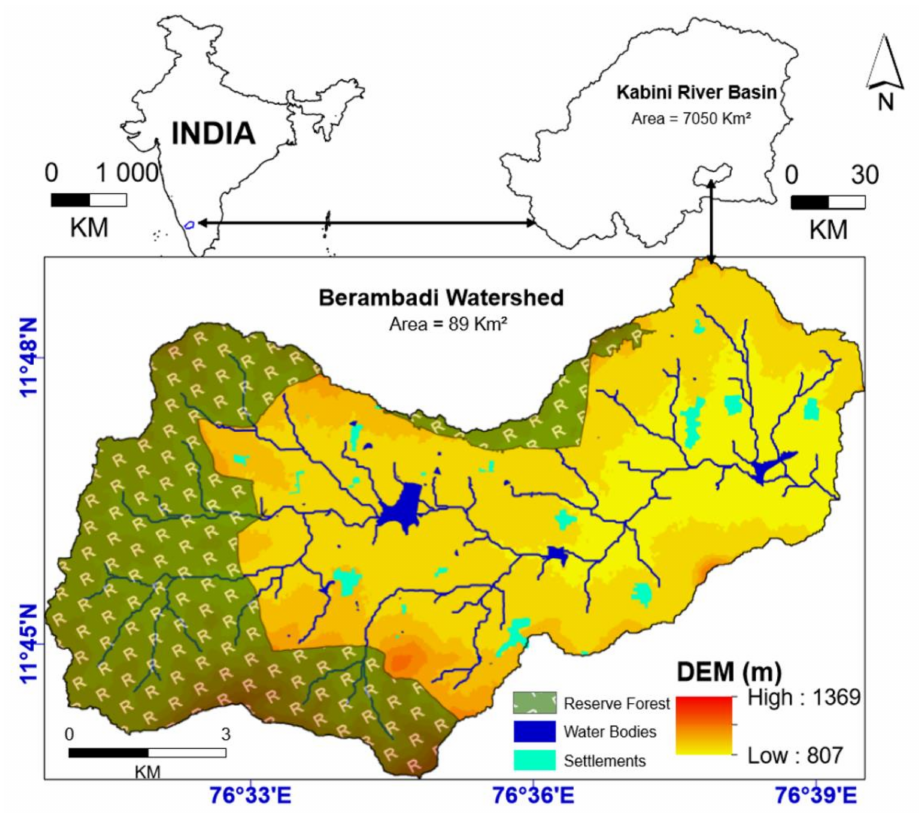
Figure 1. Location of the Berambadi watershed in the Kabini River Basin of India. Cropland (52%) and forest reserves (35%) cover 87% of the watershed, and the remain- ing 13% is covered by other land uses, such as water bodies, settlements, road networks, and wasteland [18]. Cropping seasons in the Berambadi watershed are categorized as kharif (monsoon, mid-May to mid-September), rabi (post-monsoon, mid-September to mid-January), and summer (pre-monsoon, mid-January to mid-May) according to the